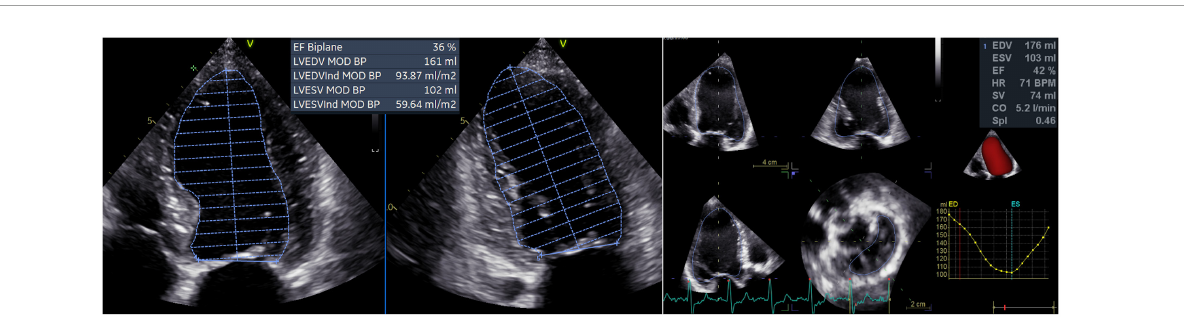
FIGURE1 Left ventricular volumes and ejection fraction calculated by two-dimensional echocardiography (left panel) and measured by three-dimensional echocardiography (right panel) . CO, cardiac output; EDV, left ventricular end-diastolic volume; ESV, left ventricular end-systolic volume; EF, ejection fraction; HR, heart rate; LV, left ventricular; MOD BP, biplane mode; SV, stroke volume; SpI, sphericity index.